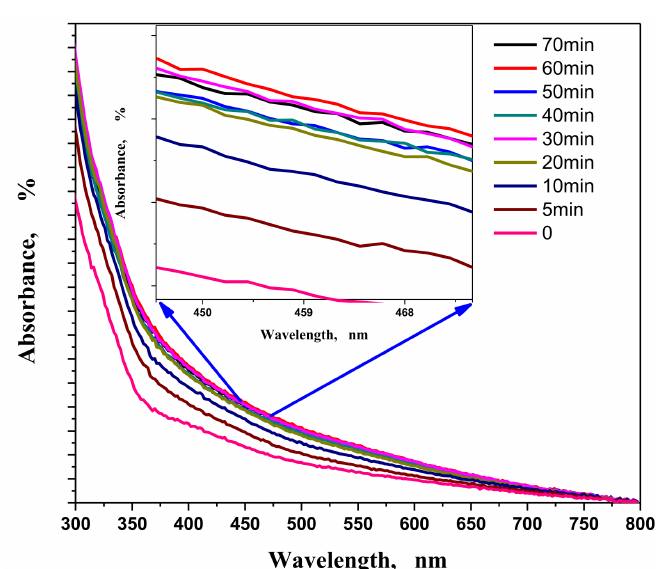
Figure 6. Contact time of the biosynthesis of palladium nanoparticles at room